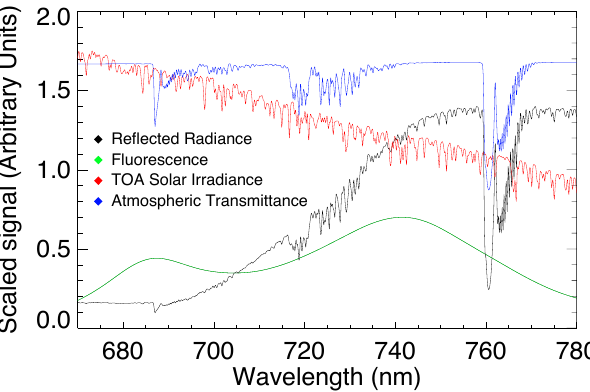
Fig. 1. Simulated solar-induced terrestrial fluorescence, typical simulated atmospheric transmittance and reflectance, and solar irradiance as a function of wavelength computed for an instrument with FWHM = 0.3 nm. The fluorescence shows red and far-red chlorophyll emission features with peaks near 685 and 740 nm, respectively. Oxygen A and B absorption bands are located near 687 and 760 nm, respectively, while water vapor absorption is shown over a broad spectral range between about 690 and 740 nm. The solar irradiance shows weak solar Fraunhofer line structure at this spectral resolution.